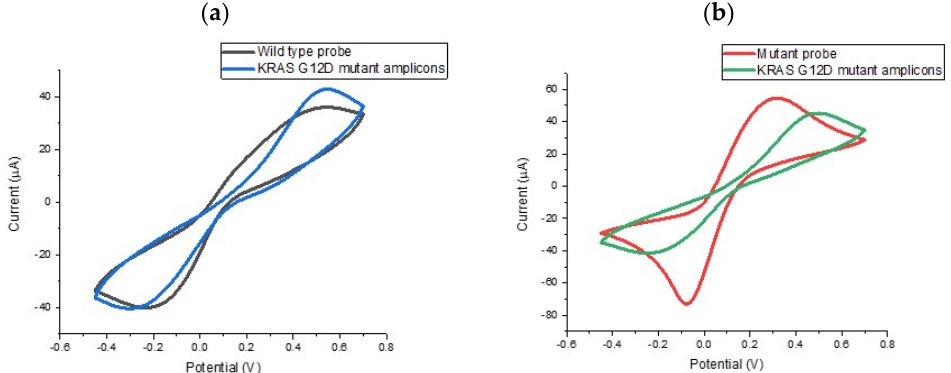
Figure 3. CV results showing hybridisation selectivity between a ( a ) wild type probe ( b ) mutant probe and a representative sample containing PCR amplified KRAS G12D mutant allele with a total KRASG12D ssDNA concentration of 0.854 ng/ μ l.